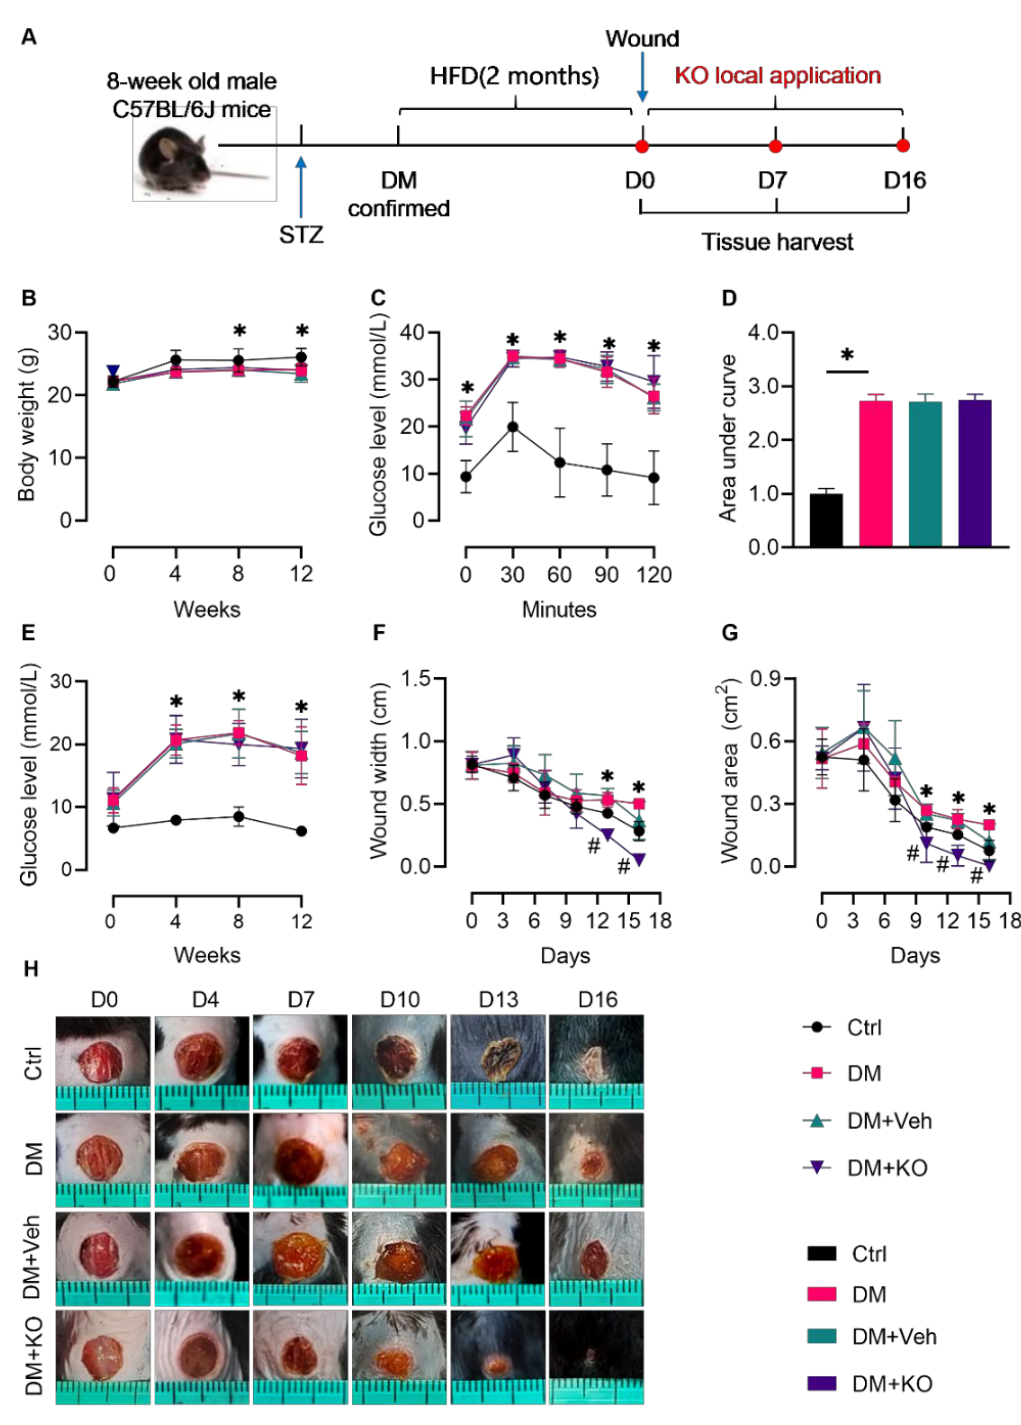
Figure 1. KO accelerated wound healing in the diabetic mice. ( A ) Schematic diagram for the induction of DM and the cutaneous wound, and the local application of KO. ( B ) Body weight. ( C ) GTT assay with the ( D ) area under the blood glucose curve quantified. ( E ) Fasting blood glucose levels post the onset of DM. (F) Wound width and ( G ) area quantified from ( H ) the images of the wounds. The data were summarized as means ± SD. *, p < 0.05 vs. Ctrl; #, p < 0.05 vs. DM. Ctrl, control; D, day; DM, diabetes mellitus; GTT, glucose tolerance test; HFD, high-fat diet; KO, krill oil; STZ, strep- tozotocin.